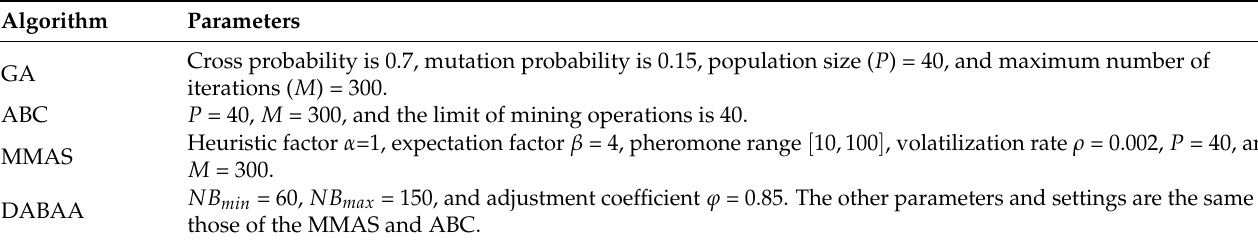
Table 4. Algorithm parameter setting.